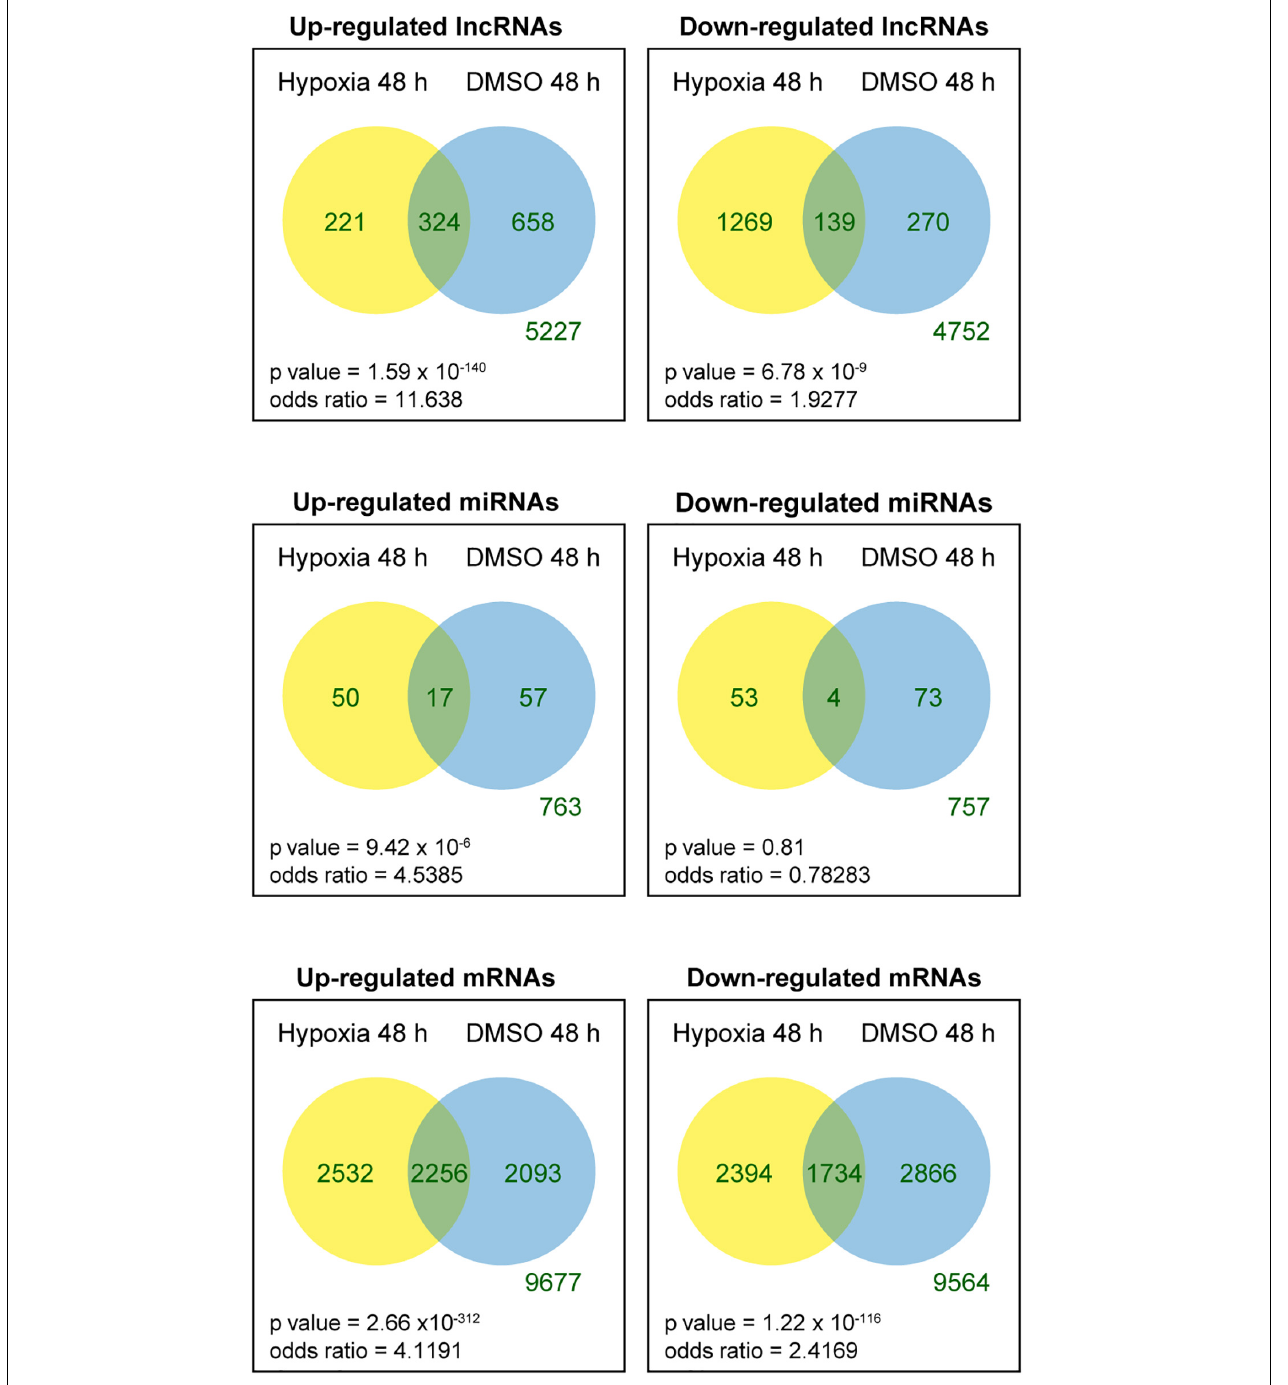
FIGURE 4 | Venn diagram of differentially expressed RNAs across the two experimental sets. Fisher exact tests were used to determine whether the genes that were up- or downregulated in one experimental set were more likely to be regulated in the same direction in the other experimental